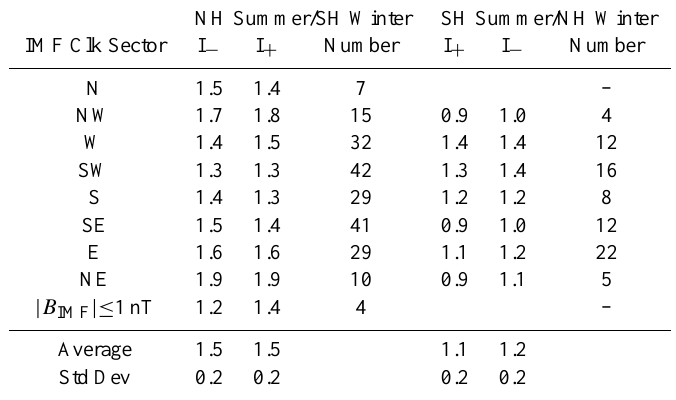
Table 1. Ratios of the NH to SH total upward current (I + in MA) and downward current (I − in MA) for the stable events common to both the NH and SH. The number of events for each IMF clock angle sector are shown in the Number column. The average and standard deviation for each column are shown in the bottom two